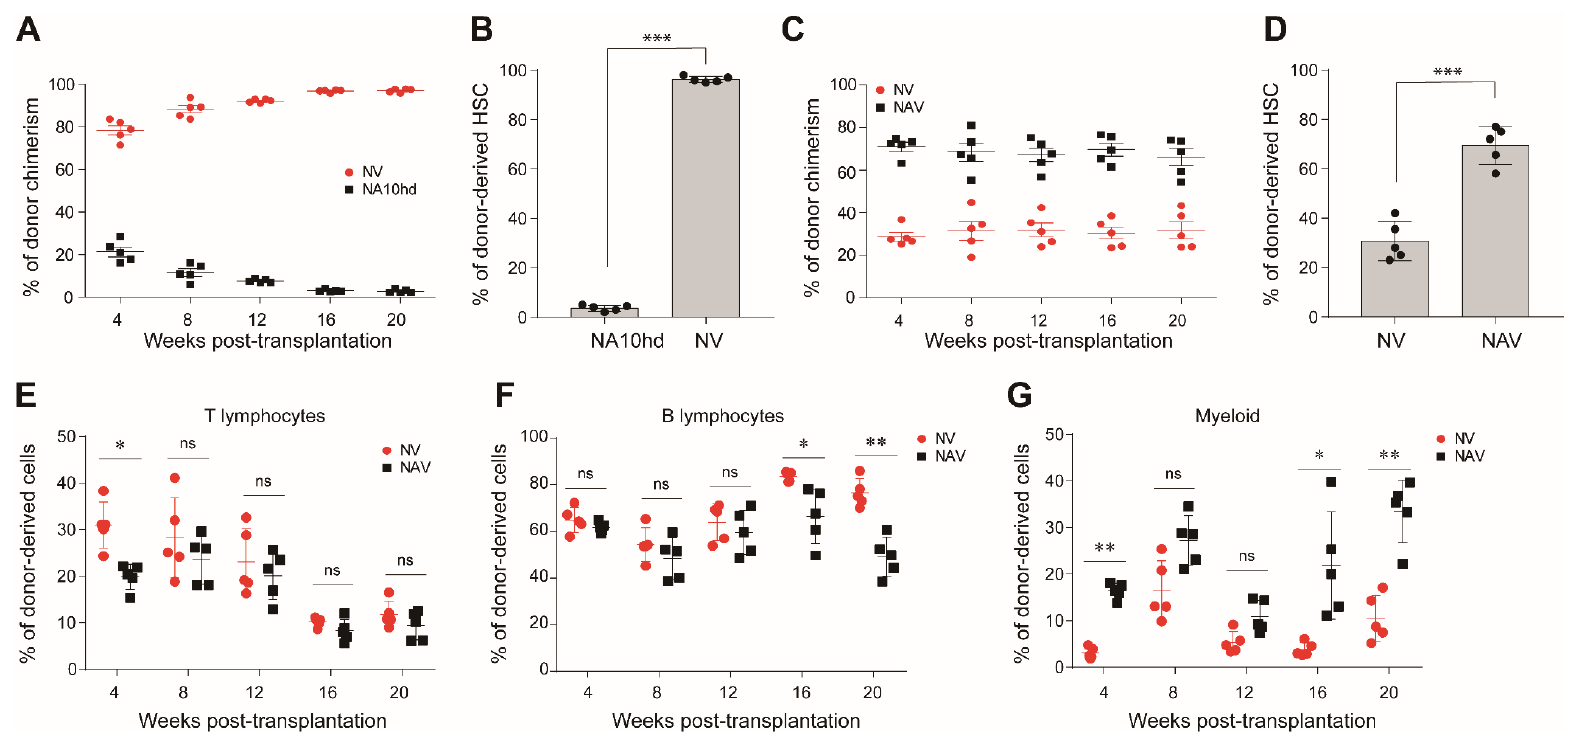
Figure 3. Comparison of engraftment competitiveness of NA10hd and NrasG12D LSL/+ ; Vav1-Cre (NV) hematopoietic stem cells. ( A ) Donor-derived cell chimerism in peripheral blood. NV and NA10hd bone marrow nucleated cells were transplanted into lethally irradiated (2 × 5.0 Gy) recipients (CD45.1) at a ratio of 1:1, and the percentage of donor cells in peripheral blood was analyzed regularly after transplantation. ( B ) The proportion of NA10hd or NV HSC in recipient bone marrow was measured by flow cytometric analysis 20 weeks post-transplantation. ( C ) Donor-derived cell chimerism in peripheral blood. NAV and NV bone marrow were transplanted into lethally irradiated (2 × 5.0 Gy) recipients (CD45.1) at a ratio of 1:1, and the donor cells in peripheral blood was analyzed regularly after transplantation. ( D ) The proportion of NV or NAV HSC were measured by flow cytometric analysis 20 weeks post-transplantation. ( E – G ) Donor-derived percentages of T lymphocytes ( E ), B lymphocytes ( F ), and myeloid cells ( G ) in peripheral blood were analyzed regualrly after transplantation. Data are represented as means ± SD. Unpaired Student’s t-test (two-tailed) was performed. N = 5 mice. * p < 0.05, ** p < 0.01, *** p < 0.001, ns indicates no significant. NrasG12D and NUP98-HOXA10HD enhance the competitiveness of HSC via distinct signaling